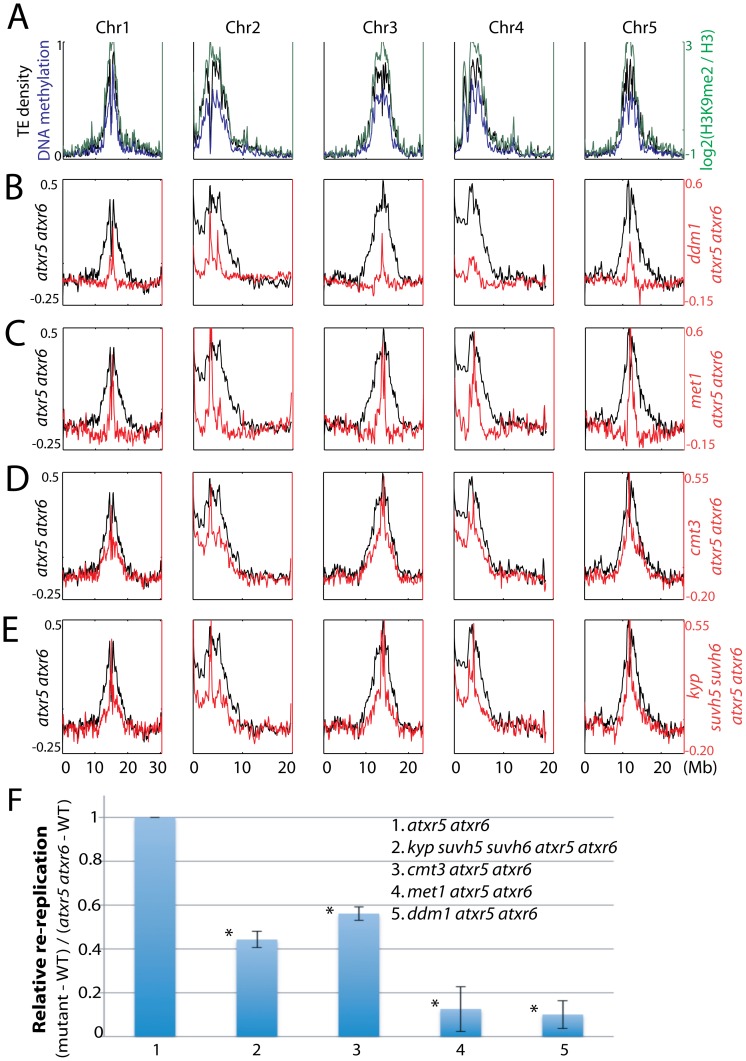
Relationship between ATXR5/6 and DNA methylation in regulating DNA replication in heterochromatin.A. Chromosomal distribution of transposable element (TE) density, DNA methylation [20] and H3K9me2 [8] data are presented to mark the locations of pericentromeric heterochromatin. B. Chromosomal views of the log2 ratio of genomic DNA reads of atxr5 atxr6 mutants to wild type (WT) are shown in black, and the log2 ratio of ddm1 atxr5 atxr6 mutants to WT are shown in red. C. met1 atxr5 atxr6 mutants, D. cmt3 atxr5 atxr6 mutants, and E. kyp suvh5 suvh6 atxr5 atxr6 mutants. F. Quantitation of reads in heterochromatin in mutants. Fraction of reads falling into previously defined pericentromeric heterochromatin [8] was calculated. *P<10−5 relative to atxr5 atxr6 mutants.